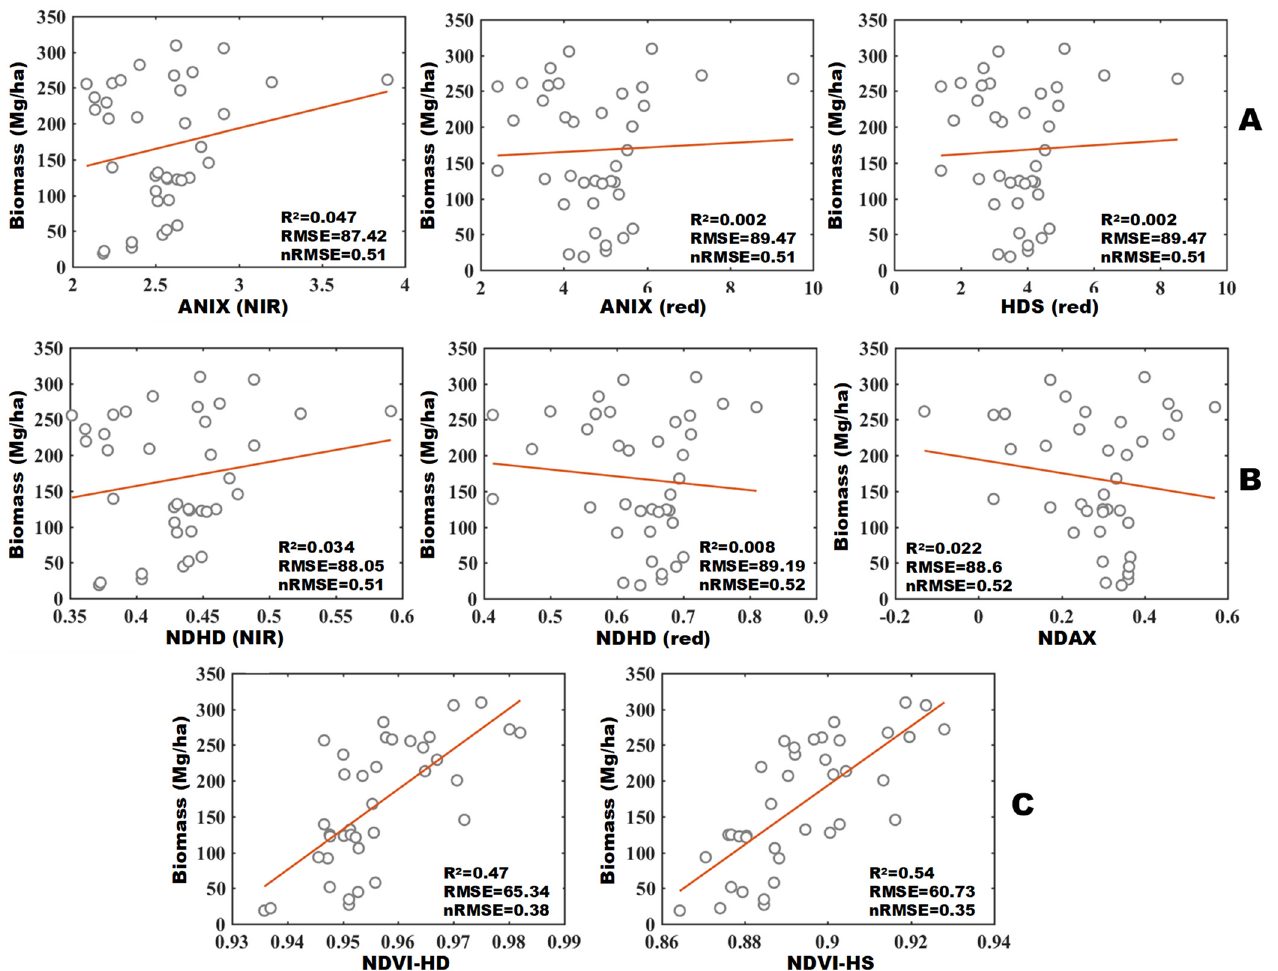
Figure 8. Linear regression results for estimating forest AGB based on the MODIS BRDF shape indicators, of which the field-based biomass data are from Appendix A Table A1; the BRDF shape indicators of row ( A ) were originally used for landcover inversion, row ( B ) for CI, and row ( C ) for LAI.